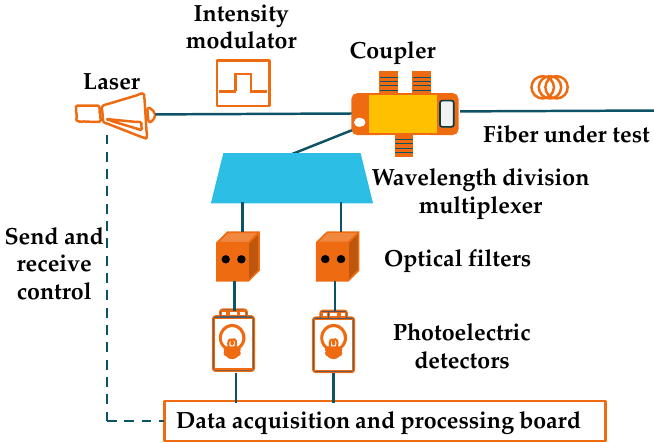
Figure 13. The typical system architecture of ROTDR.